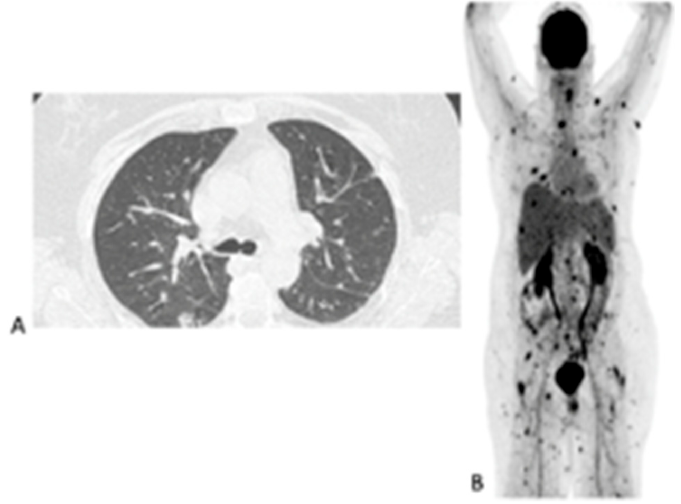
Figure 4. Sixty-three-year-old female with acute myeloid leukemia on treatment for pulmonary aspergillosis. [ 18 F]FDG PET/CT was performed because there was unexplained fever, and the IFI lesions seen on HR CT ( A ) were similar to in the HR CT scan performed a month and 2 months earlier. [ 18 F]FDG PET/CT scan ( B ) showed multiple IFI lesions outside the thorax, providing an explanation for the persistent fever.